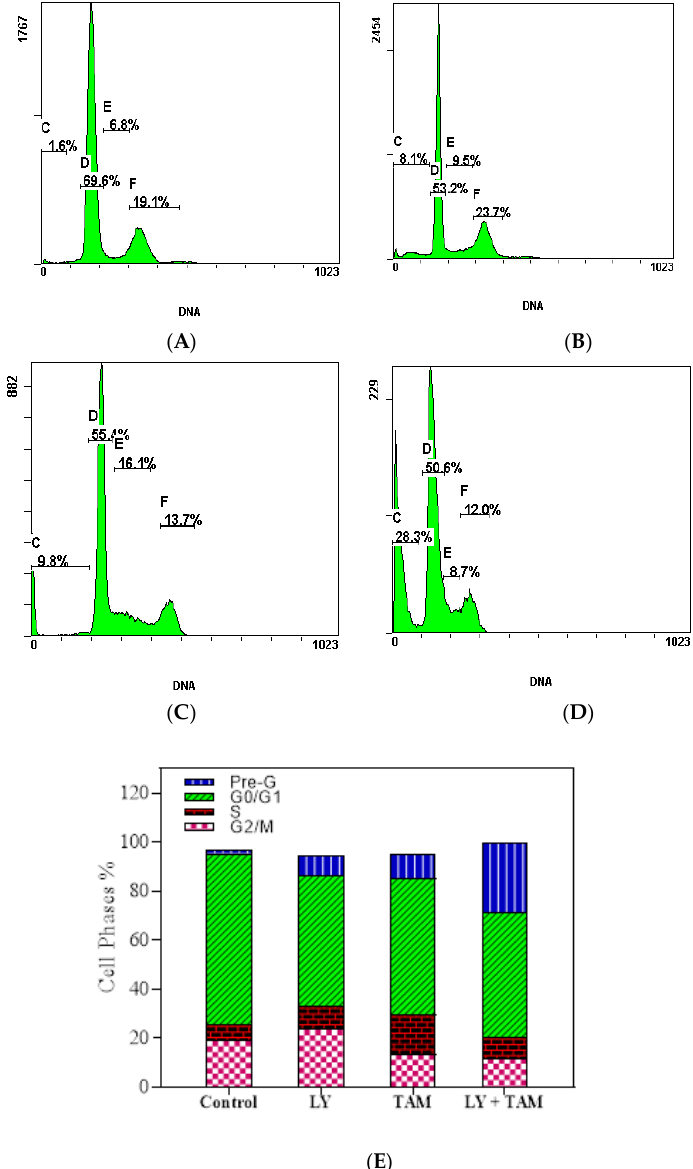
Figure 6. Histograms represent DNA cell cycle distribution in MCF-7 cells treated with ( A ): control, ( B ): LY, ( C ): TAM, and ( D ): LY + TAM combination for 24 h. ( E ): columns represent the flow cytometry data analysis as means of the percentages of pre-G 1 , G 0 /G 1 , S, and G 2 /M ( n = 3, three independent experiments).